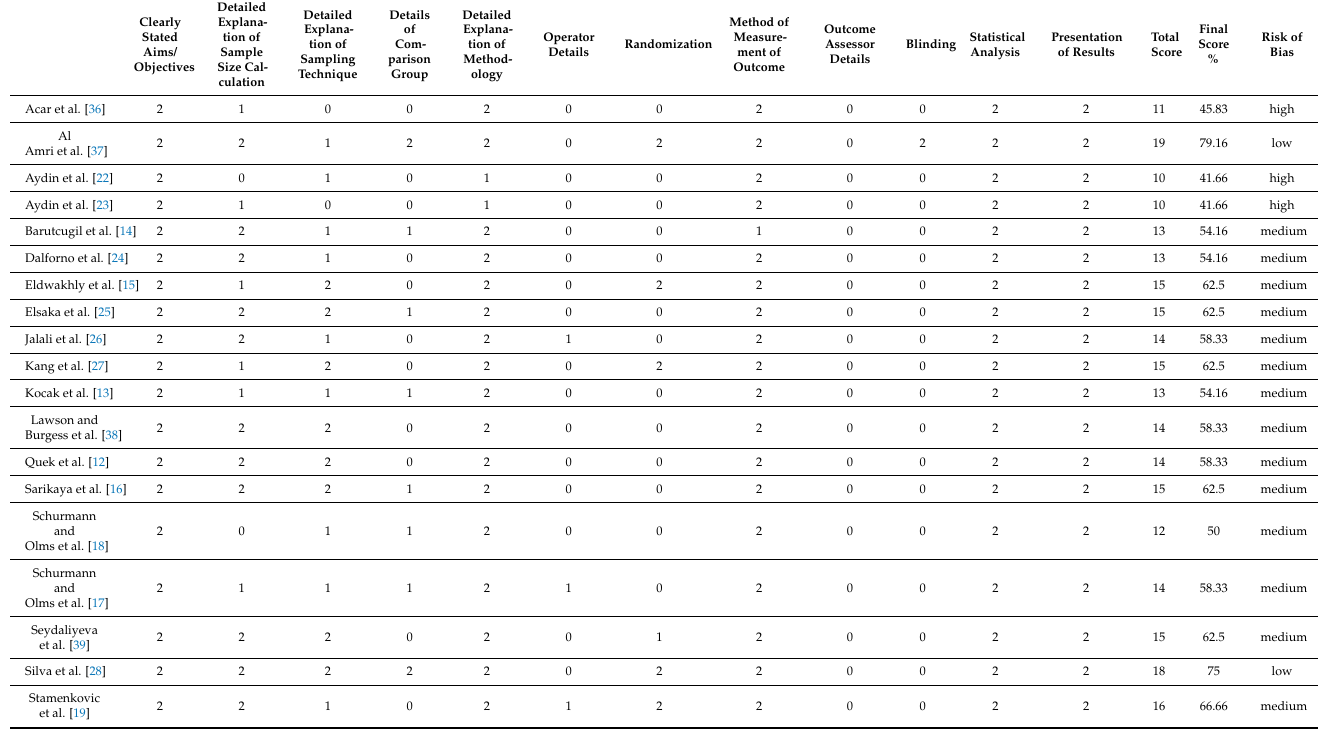
Table 5. Risk of